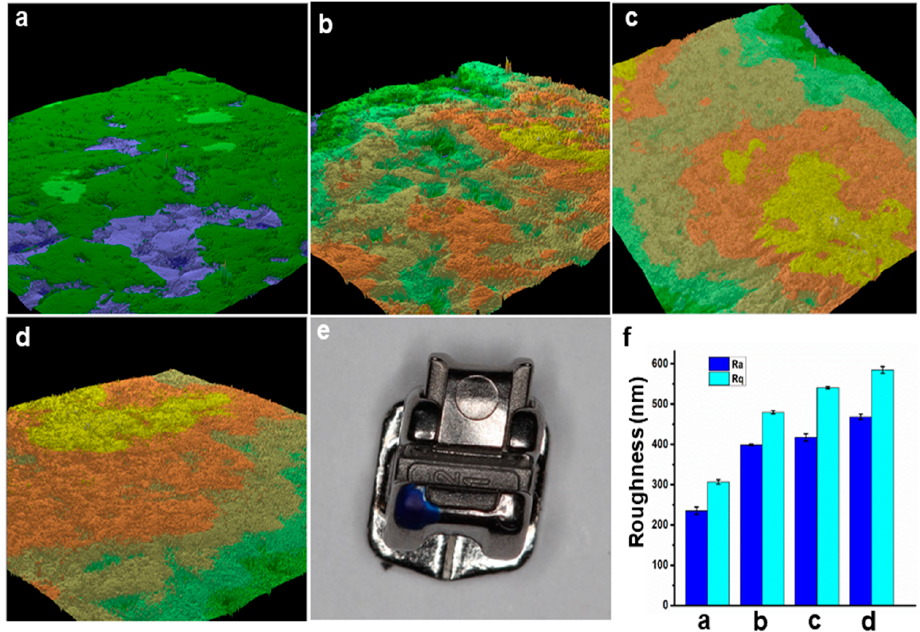
Figure 1. 3D surface profiling of ( a ) OB ( b ) OB-POX ( c ) OB-POX/L-Trp ( d ) OB-POX/D-Trp, ( e ) Da- mon Q orthodontic bracket. ( f ) Comparison of surface roughness of a—OB, b—OB-POX, c—OB- POX/L-Trp, d—OB-POX/D-Trp, evaluated from surface